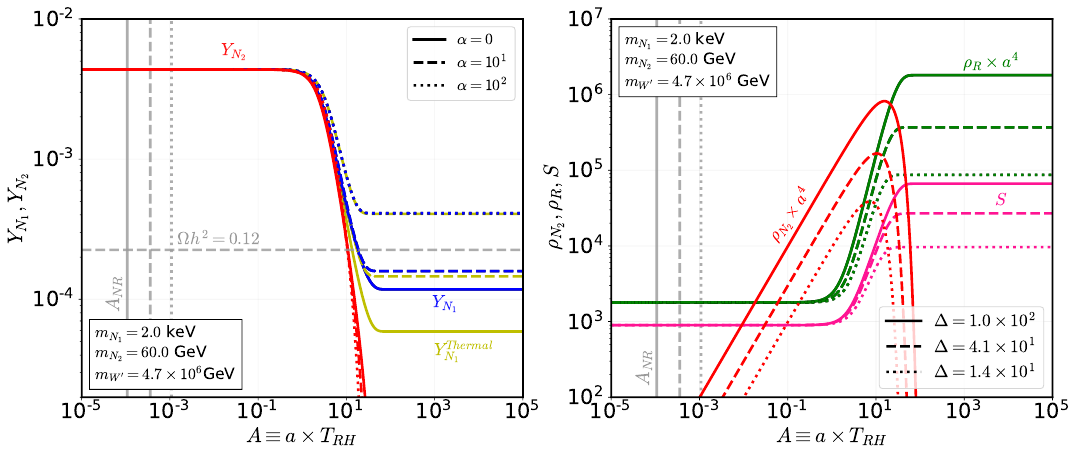
Figure 3 . Evolution of coupled equations (4.1), (4.6), and (4.9) for α = 0 , 10 , 100 (solid, dashed and dotted curves, respectively). Left panel: evolution of total (thermal and non-thermal contribution) Y N (blue), only thermal contribution Y Thermal (yellow) and Y N (red). Right panel: curves of N 1 1 2 entropy S (pink), ρ N × a 4 (red) and ρ R × a 4 (green), also shown are how the value of ∆ changes 2 as we increase α ( ∆ = 100 , 41 and 14 , for respective α